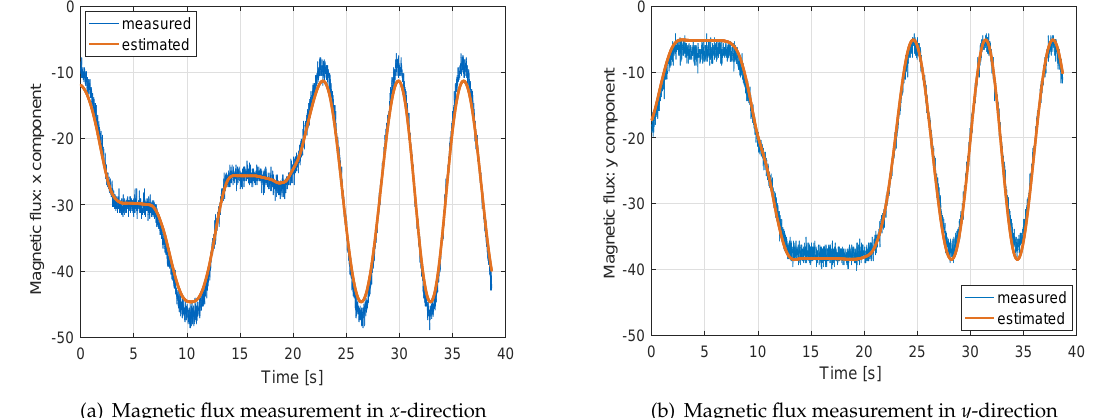
Figure 5. Magnetic flux measurements in sensor-fixed frames: the measured magnetic flux in x - and y -directions depends on the heading and is quite noisy. The least-squares estimate of the magnetic flux is much less noisy, as the estimation combines the measurements from 40 s to determine the 3D magnitude of the magnetic flux and the 3D biases.